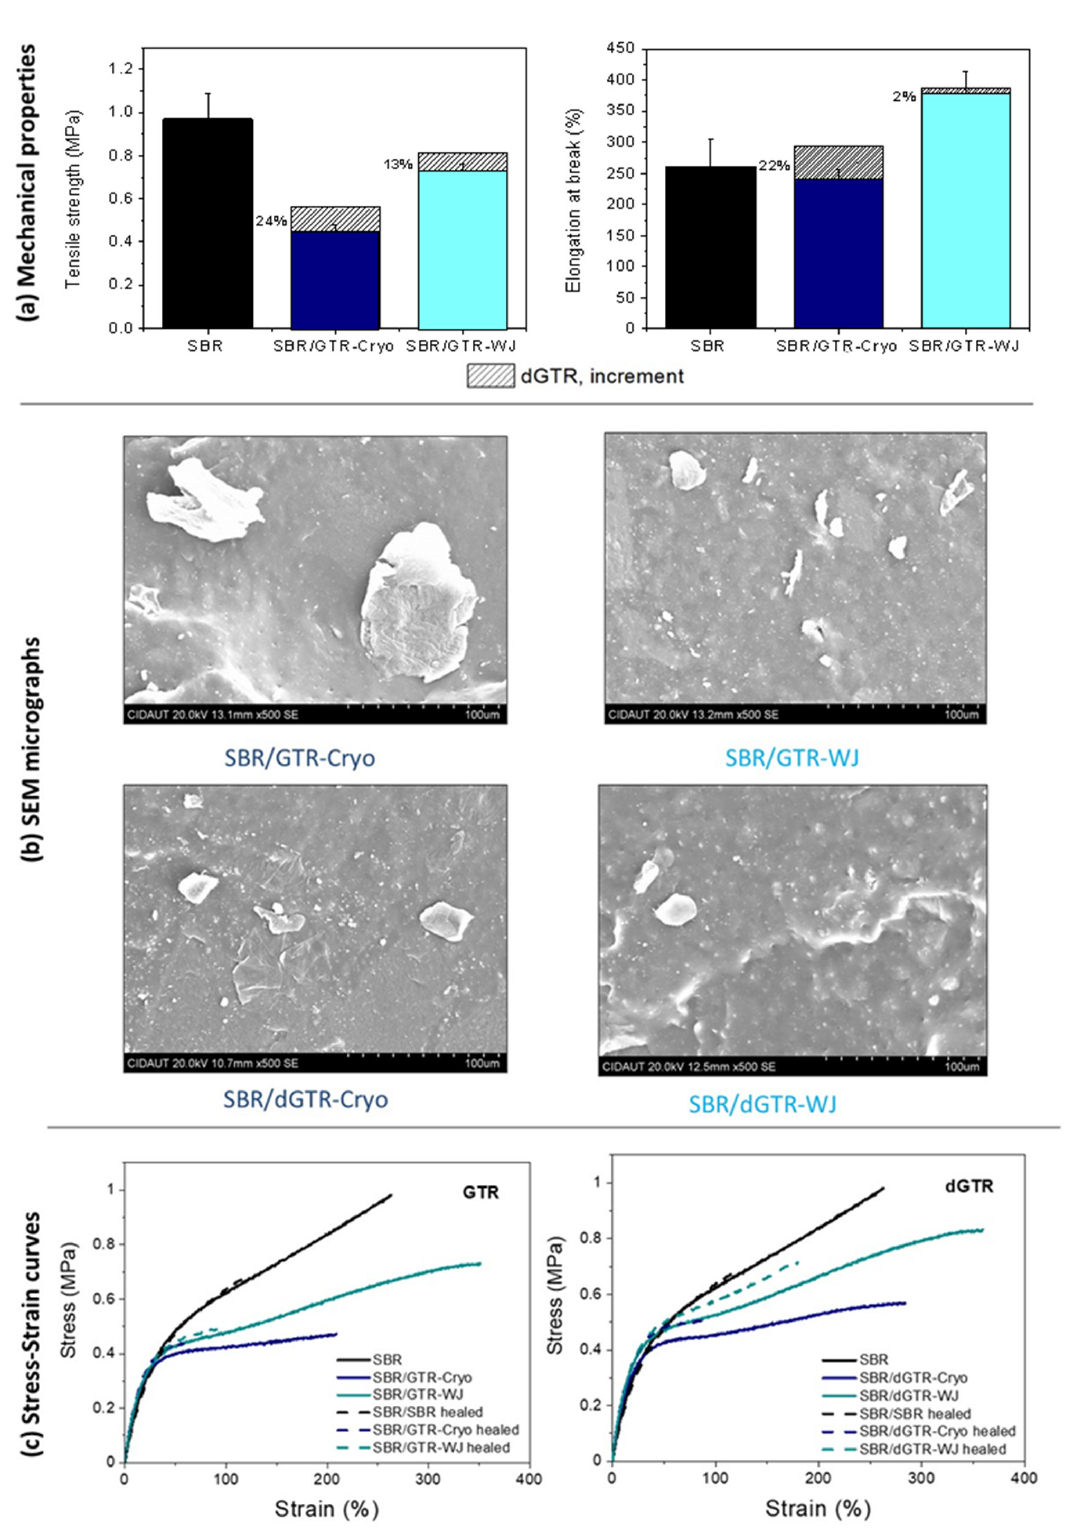
Figure 6. ( a ) Mechanical properties and ( b ) SEM micrographs of SBR/GTR and SBR/dGTR com- pounds; ( c ) tensile strength of self-healing SBR compounds with GTR and dGTR in the pristine (solid lines) and healed states (dashed lines).